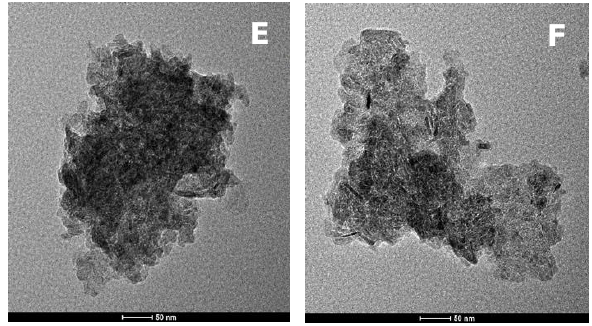
Figure 4. TEM images of ( A , B ) 15 wt%Ni/ γ -Al 2 O 3 , ( C , D ) 15 wt%Ni-3Co/ γ -Al 2 O 3 , and ( E , F ) 15 wt%Co/ γ -Al 2 O 3 .